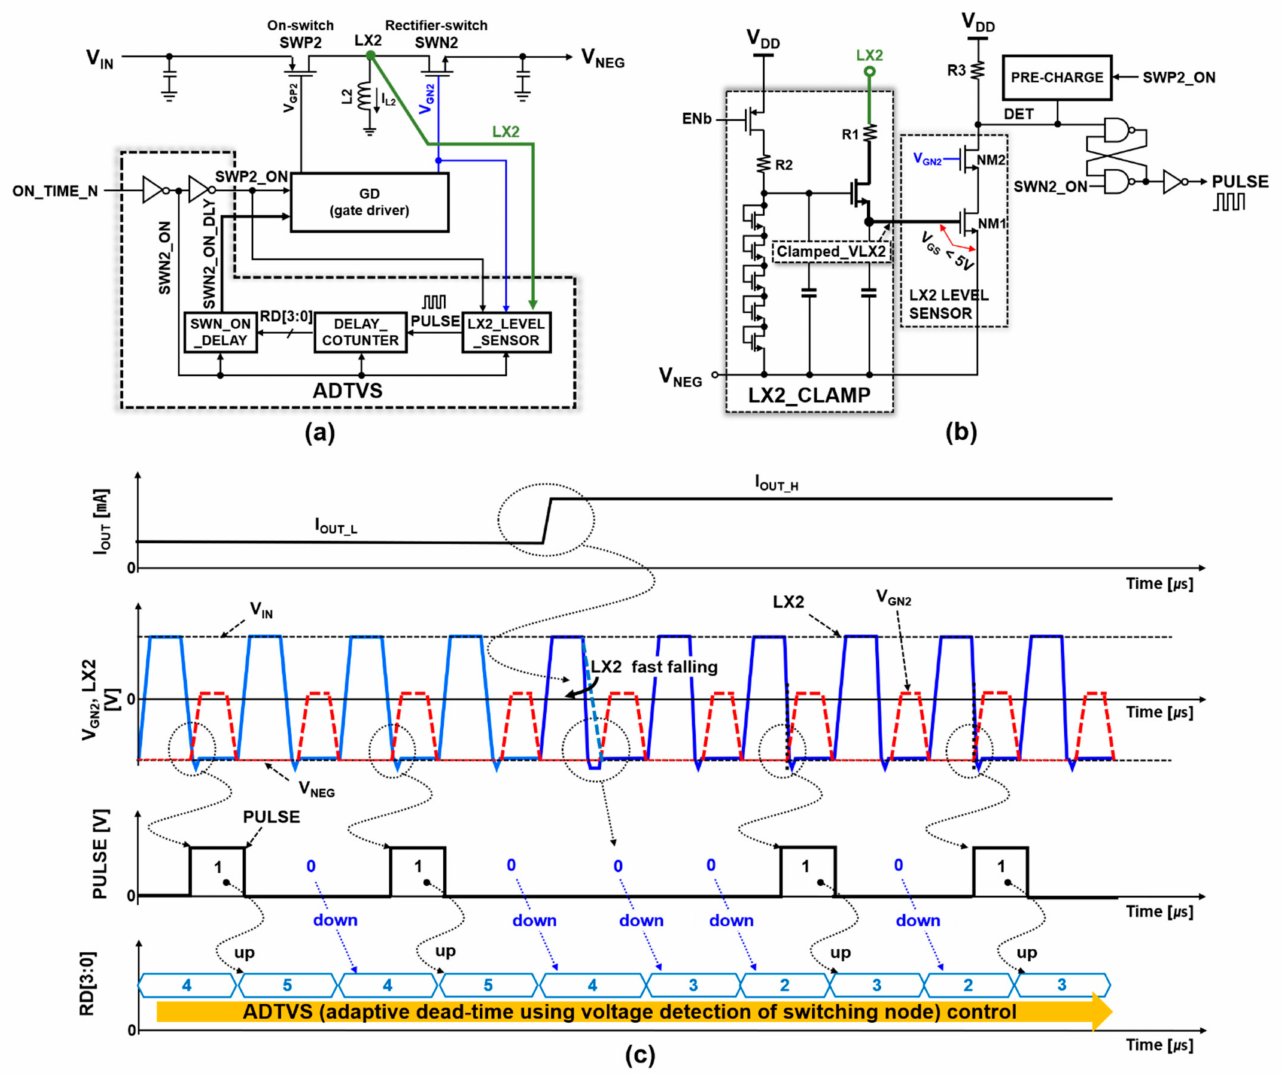
Figure 7. Proposed ADTVS circuit: ( a ) ADTVS circuit; ( b ) LX2_LEVEL_SENSOR circuit; ( c ) timing diagrams of the